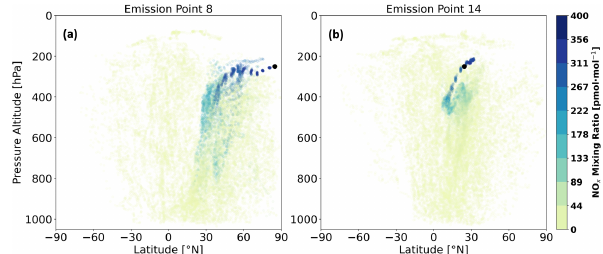
Figure E1. Transport of emitted NO x released in N. America dur- ing January 2014 at (a) emission point 8 within a meridional tilt and at (b) emission point 14 outside the tilt but within the north- ern westerly. The black dot denotes the emission point. The NO x mixing ratio is expressed in picomoles per mole (pmolmol − 1